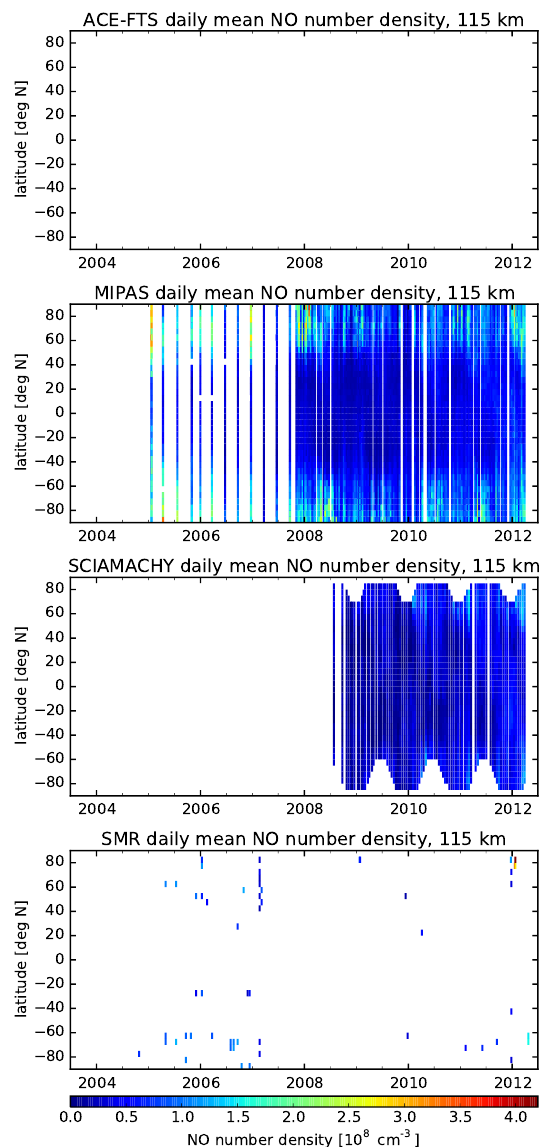
Figure A5. NO zonal mean time series at 115km from ACE-FTS, MIPAS, SCIAMACHY, and SMR (from top to